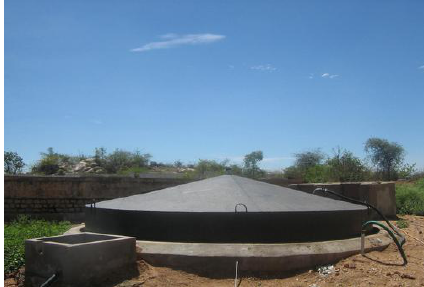
Figure 3. Typical example of a biogas supplied via flexible pipeline in India [48] (reproduced with permission from Reddy,